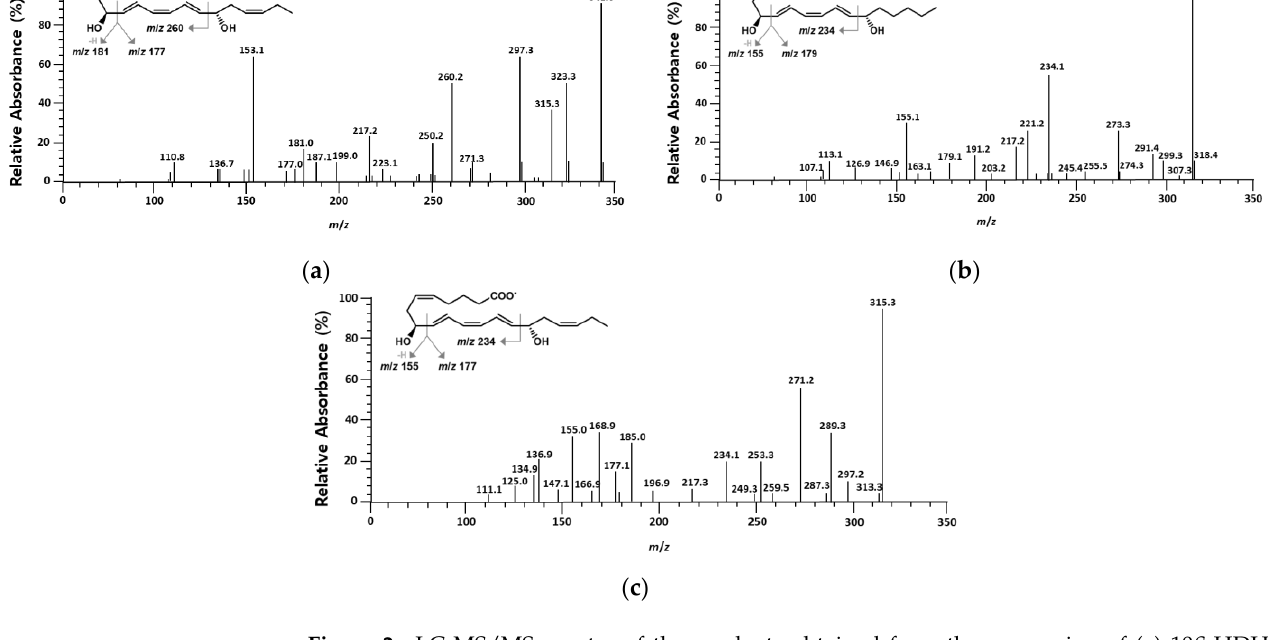
Figure 2. LC-MS/MS spectra of the products obtained from the conversion of ( a ) 10 S -HDHA, ( b ) 8 S -HETE, and ( c ) 8 S -HEPE by BT 15 S LOX. The inset shows the major fragments formed. The stereochemistry of 10,17-DiHDHA was confirmed by 1D and 2D Nuclear mag- netic resonance (NMR) spectroscopy (Table 1 and Figure S3) by comparing with a previ- ous report [26]. The coupling constants of J 11-12 and J 15-16 were 15 Hz, indicating that the double bond is in E geometry at 5.70 and 6.68 ppm, respectively. Four Z geometric double bonds were contained at 5.45 – 5.31 ppm of H-4,7,19 and 5.93 ppm of H-13. The 10S-H and 17 S -H peaks had 4.14 and 4.12 ppm, respectively, indicating that the product obtained from the conversion of 10S-HDHA by BT 15 S LOX is 10 S ,17 S -DiHDHA and that BT 15 S LOX is a PDX-producing enzyme. Table 1. 1 H and 13 C NMR data of PDX.